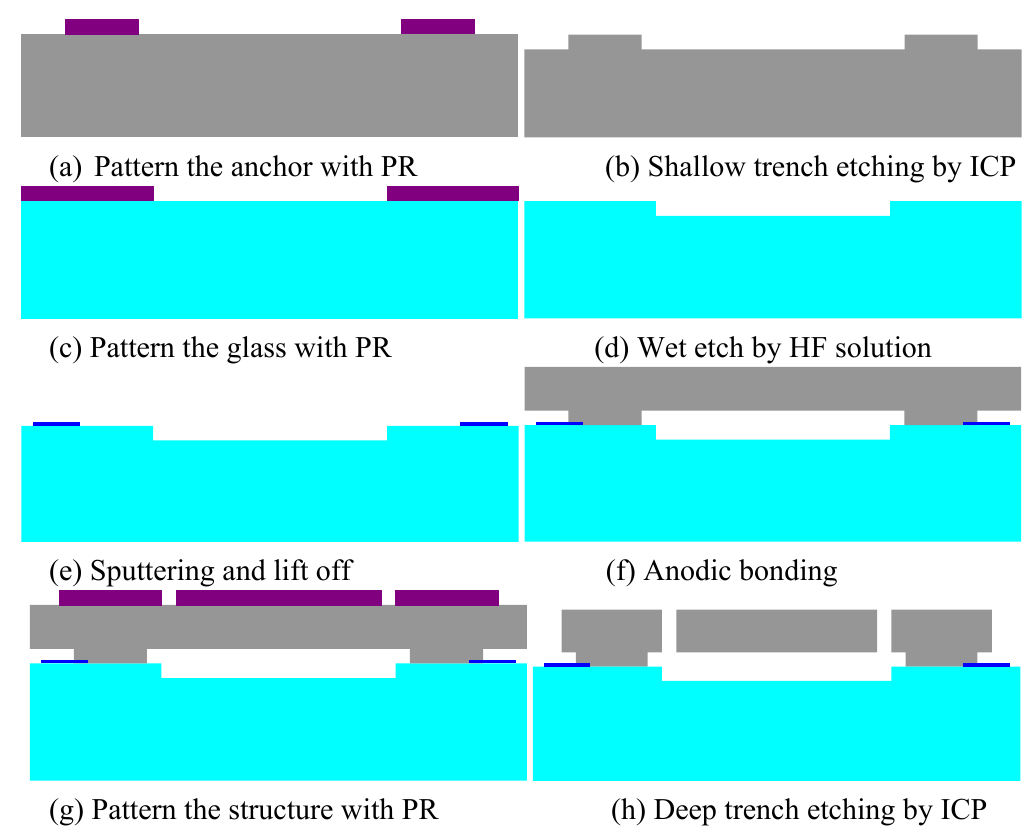
Figure 2. The process flow for the mechanical sensing element